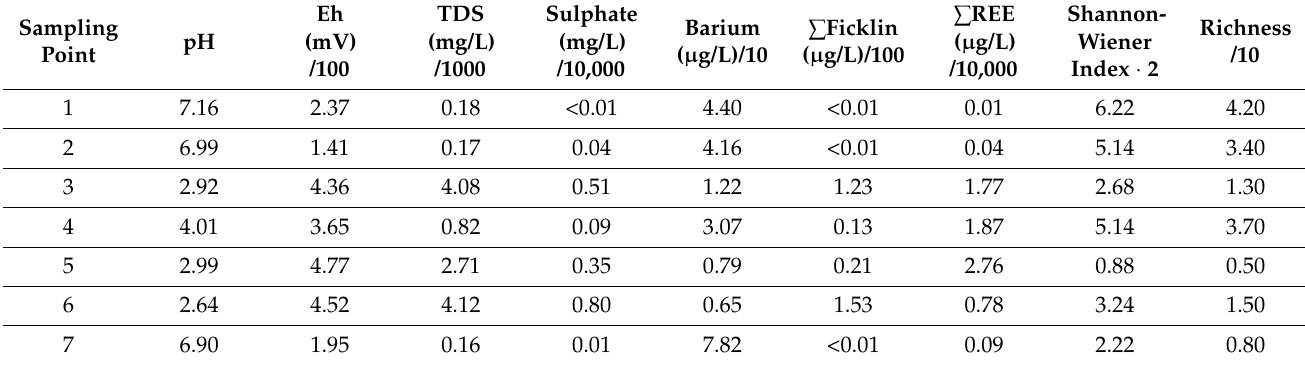
Table A1. Values of the parameters of each sampling point. Their absolute value was standardized between 0 and 10 by means of multiplication/division